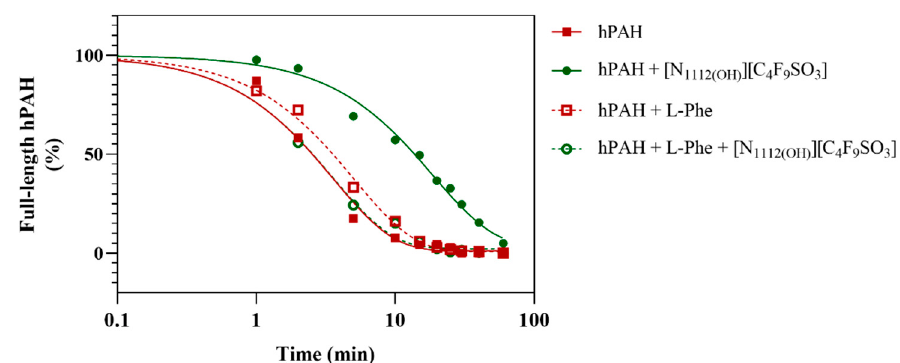
Figure 4. Limited proteolysis of hPAH by trypsin. Degradation of full-length hPAH by trypsin, in the absence and presence of [N 1112(OH) ][C 4 F 9 SO 3 ] and/or L-Phe. Table 3. Effect of L-Phe on the proteolytic stability of hPAH in the presence and absence of [N 1112(OH) ][C 4 F 9 SO 3 ] and L-Phe. Proteolytic rates (k obs ) were obtained from limited trypsin proteolysis.